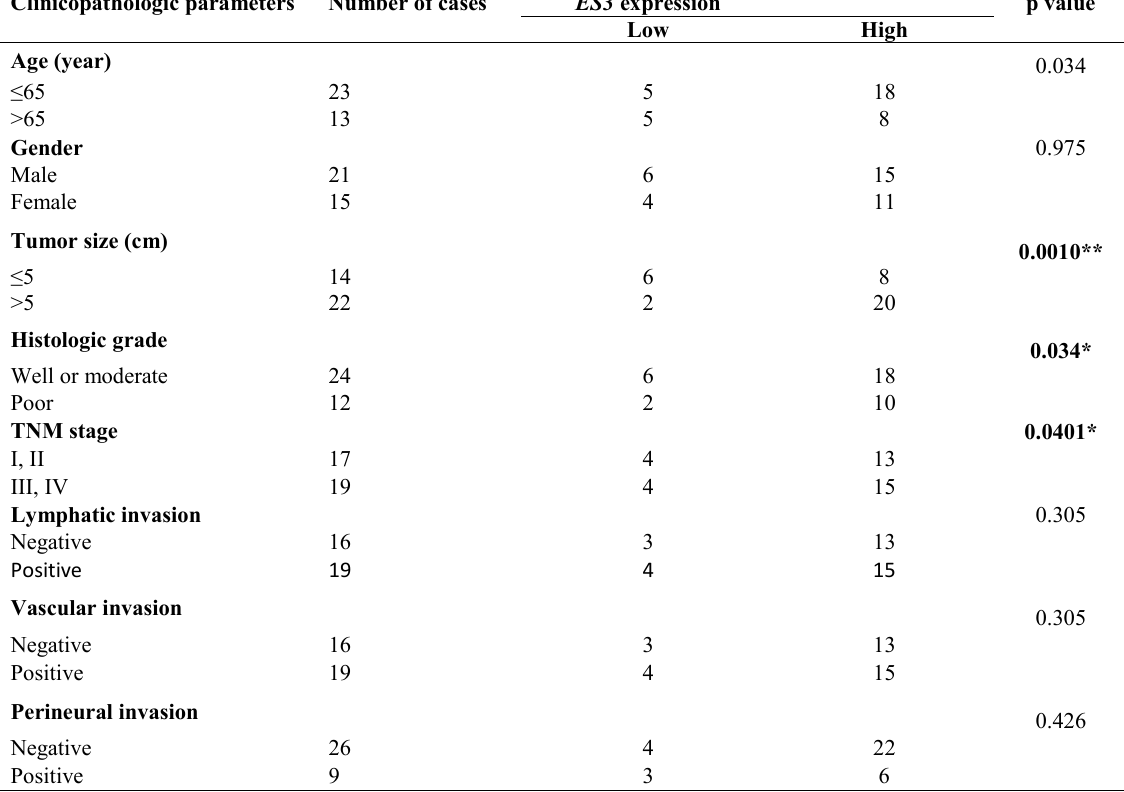
Table 1. The correlation between the expression level of ES3 and clinicopathologic parameters of CRC tissues. Clinicopathologic